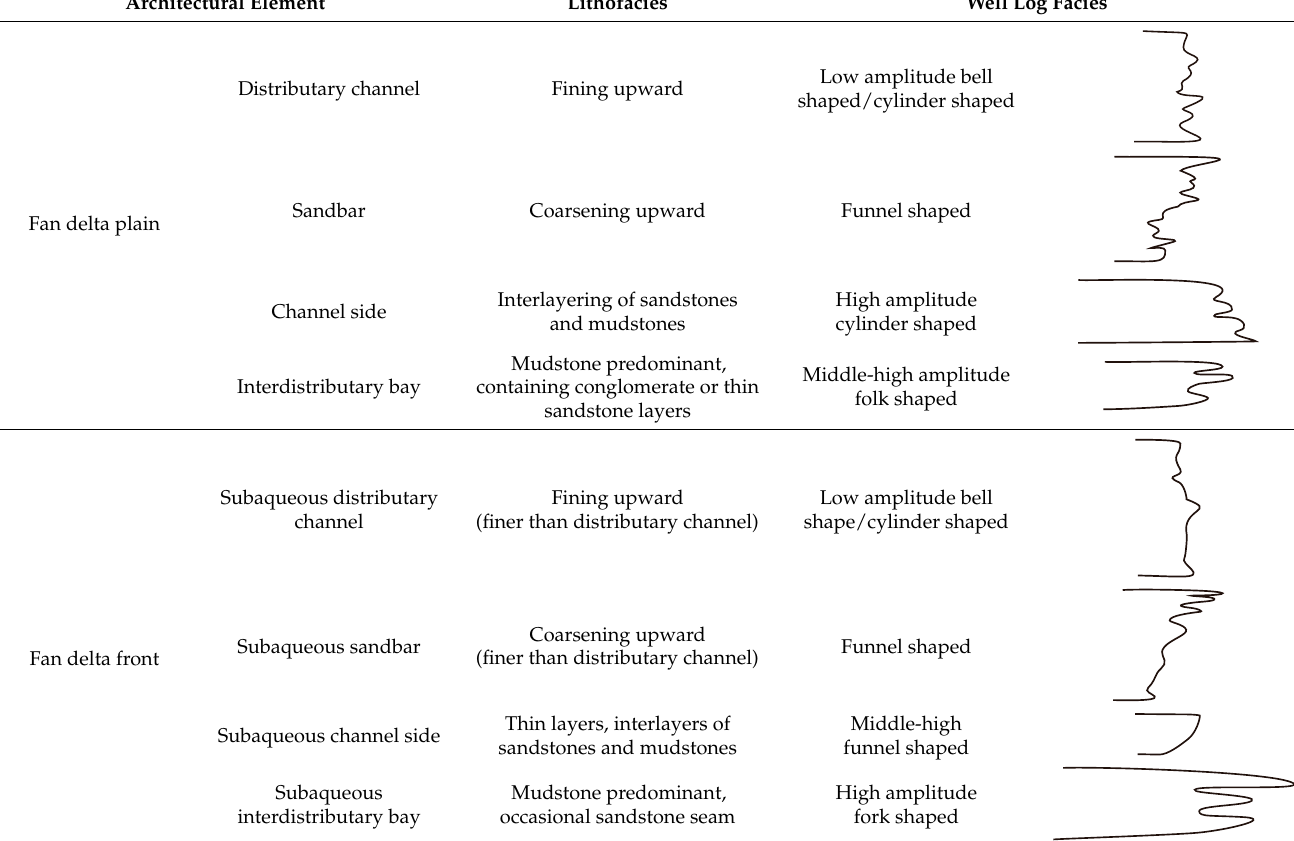
Table 5. Lithofacies and well log interpretations of architectural elements.